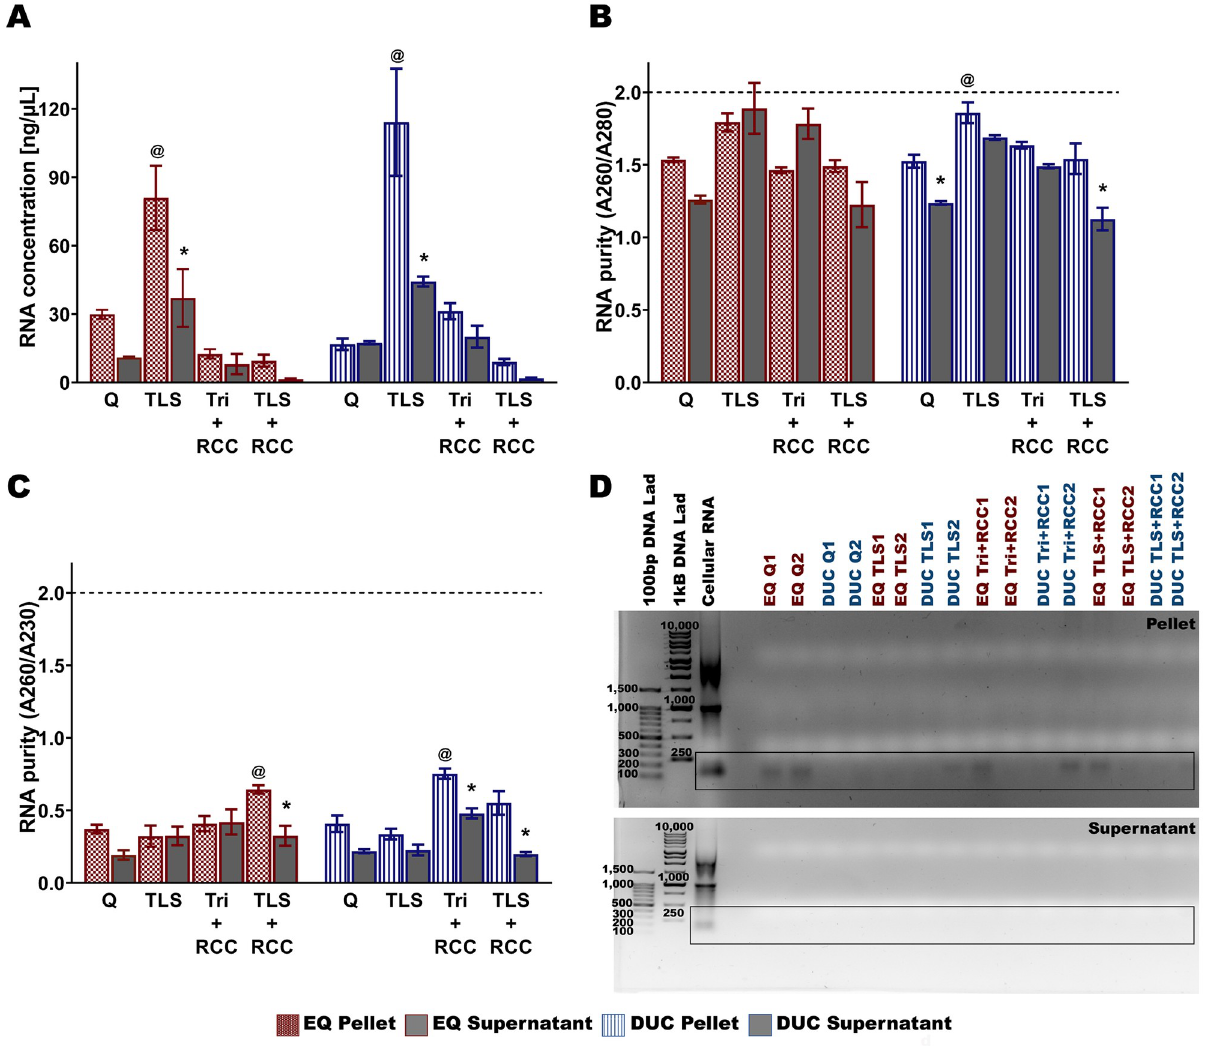
Fig 8. RNA yield [ng/ μ L], purity and quality of bovine milk-derived exosome pellets and supernatants isolated via ExoQuick (EQ) precipitation and differential ultracentrifugation methods (DUC). RNA was extracted using four protocols, 1) QIAzol + miRNeasy MiniKit (Q), 2) TRIzol LS (TLS), 3) TRIzol + RNA Clean and Concentrator Kit (Tri+RCC), and 4) TRIzol LS + RNA Clean and Concentrator Kit (TLS+RCC). RNA concentration [ng/ μ L] (A), RNA purity—absorbance at 260 nm/280 nm (B), and absorbance at 260 nm/230nm (C), and 1% TAE agarose gel electrophoresis (D) of the RNA samples. Data are mean ± SEM with n = 6 independent trials/group. @ Main effect of RNA extraction protocol (p � 0.05). � Significant difference in RNA concentration and purity between the pellets and supernatants (p � 0.05).